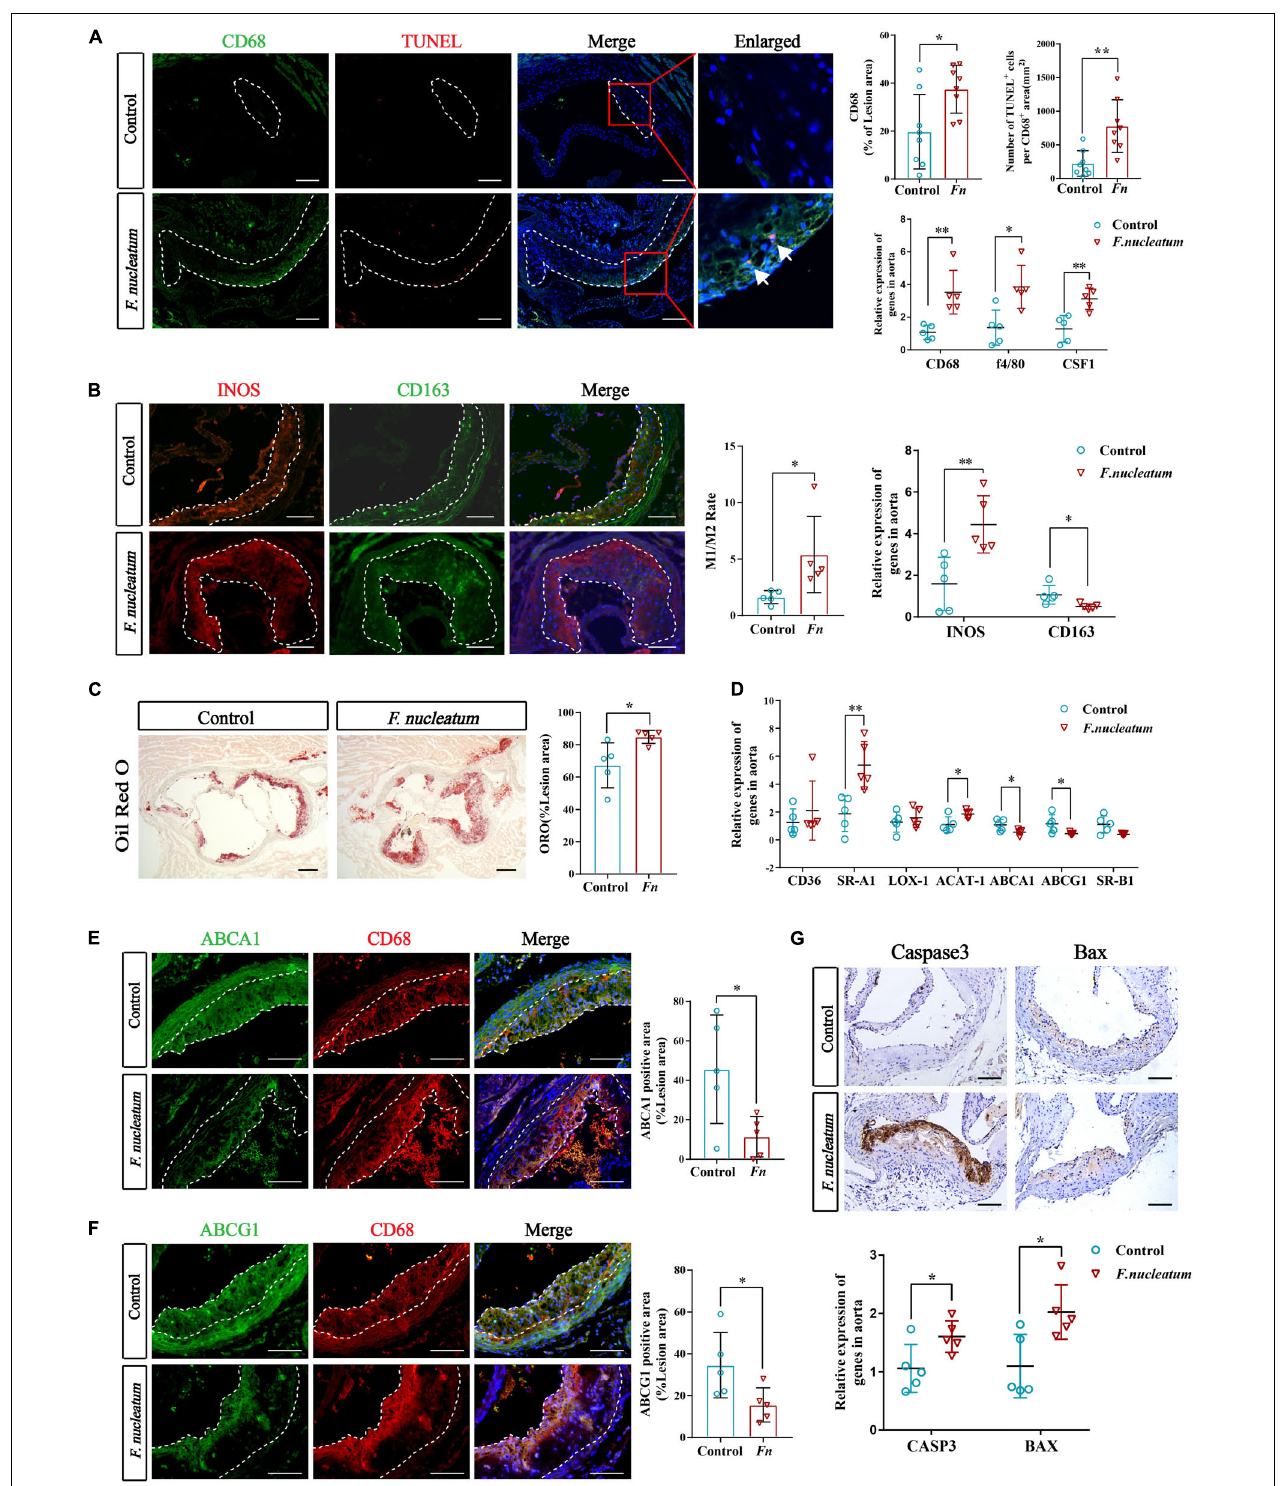
FIGURE 2 | F. nucleatum promotes monocytes/macrophage accumulation, polarization, foam cell formation, and apoptosis in the plaque microenvironment. (A) The left panel shows representative aortic sinus cross–sectional analysis for macrophage content via immunodetection of CD68 and apoptotic cell via TUNEL staining (the white arrows in enlarged panels). Dashed lines show the boundary of the plaques. Scale bars, 100 µ m. Data are expressed as the average percentage of CD68–positive in the lesion area, and the number of TUNEL–positive cells per CD68–positive area ( n = 8, each group) in the right panel. The relative mRNA levels